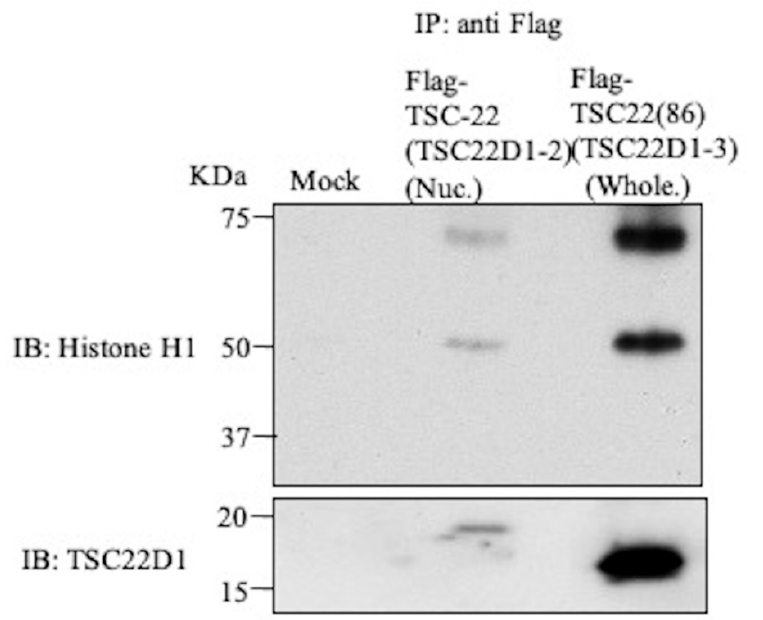
Figure 7. Intracellular binding of TSC-22 (TSC22D1-2) with histone H1. IP-Western blotting using nuclear extract after DNA damage in Flag-TSC-22 (TSC22D1-2)-transfected cells. In detection using anti-histone H1 or anti-GNL3 antibody, histone H1 was clearly detected.